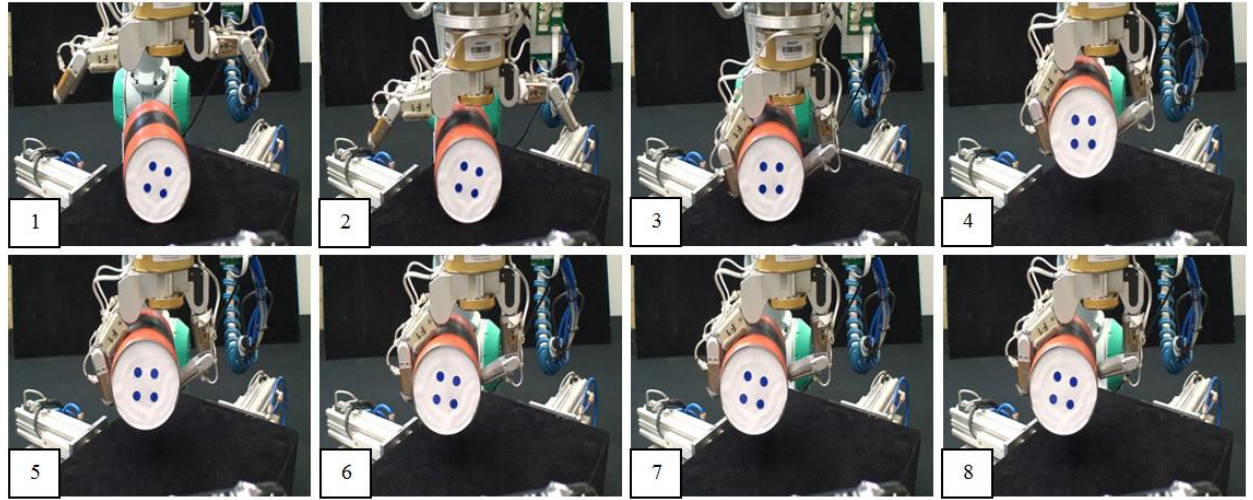
Figure 11. Sequence of frames of the manipulation phase of the robotic